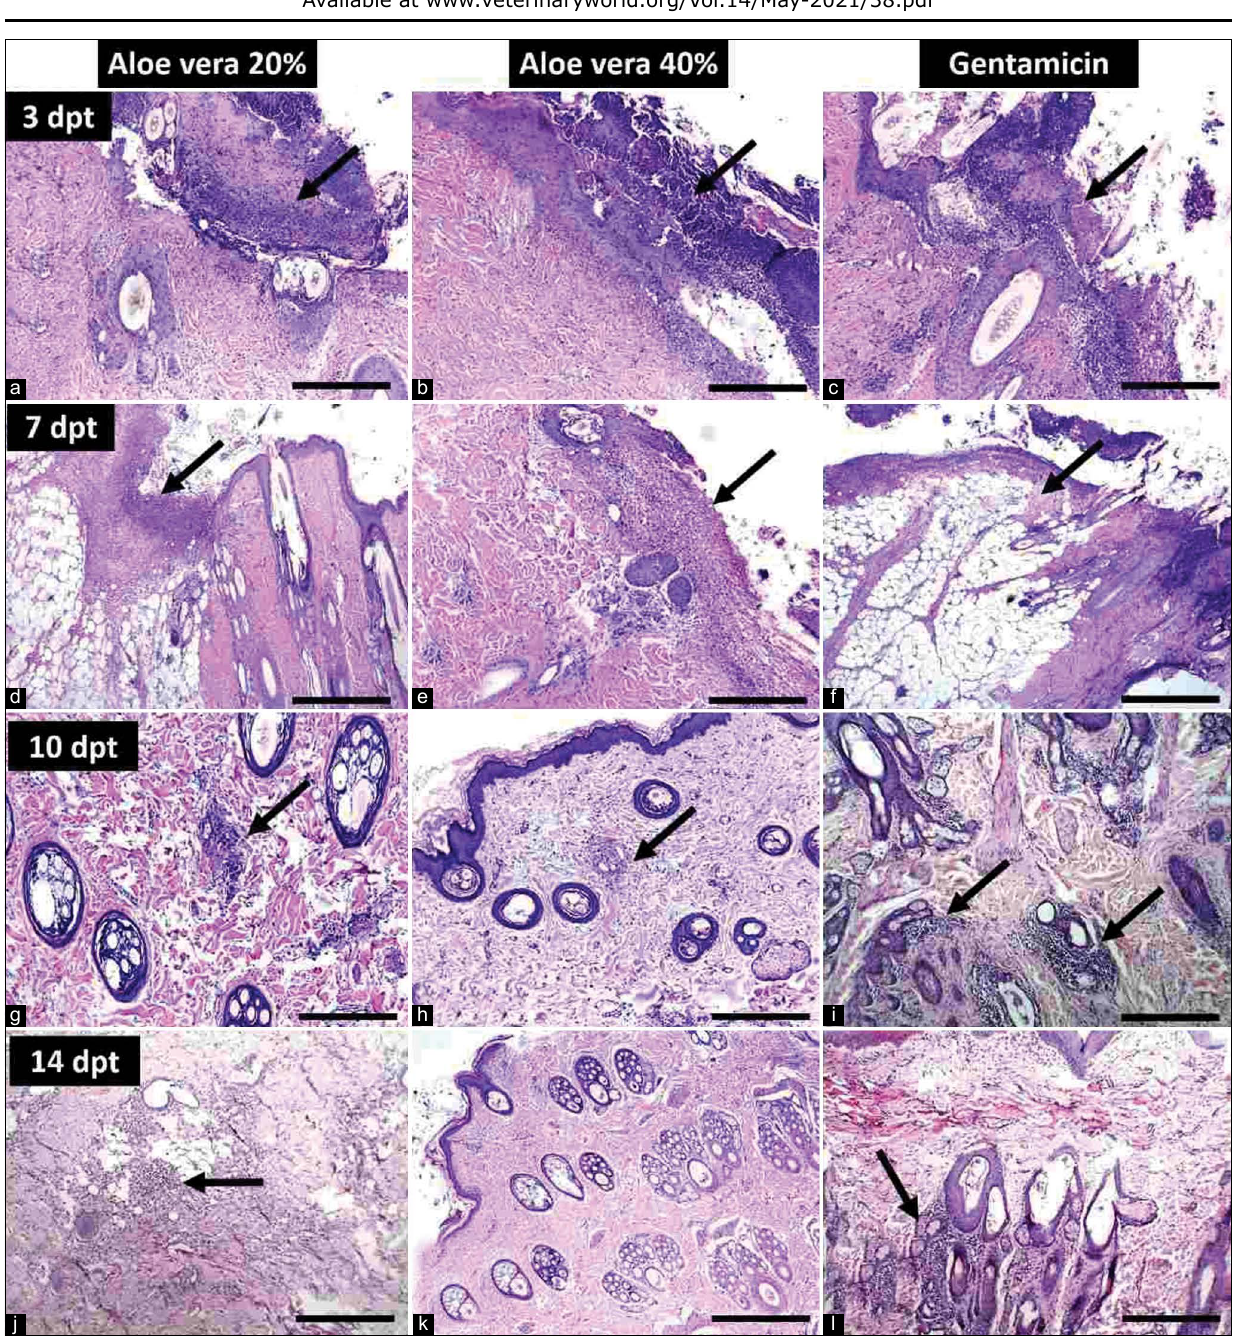
Figure-5: Treated group. On 3 rd days post-treatment (DPT), (a) skin treated with Aloe vera ointment 20% showed epidermal necrosis, edema, severe neutrophilic infiltration, and hair folliculitis; H and E 10×. (b) Skin treated with A. vera ointment 40% showed epidermal necrosis, edema, and moderate neutrophilic infiltration; H and E 10×. (c) Skin treated with gentamicin ointment 0.1% showed epidermal necrosis, edema, severe neutrophilic infiltration, and hair folliculitis; H and E 10×. On 7 th DPT, (d) Skin treated with A. vera ointment 20% showed focal suppurative inflammation in the subcutaneous fat; H and E 10×. (e) Skin treated with A. vera ointment 40% showed epidermal necrosis with few neutrophils’ infiltration; H and E 4×. (f) Skin treated with gentamicin ointment 0.1% showed diffuse suppurative inflammation in the epidermis and subcutaneous fat; H and E 4×. On 10 th DPT, (g) skin treated with A. vera ointment 20% showed mild inflammation in the dermis and around the hair follicles; H and E 10×. (h) Skin treated with A. vera ointment 40% showed mild inflammatory zone in the dermis; H and E 10×. (i) Skin treated with gentamicin ointment 0.1% showed mild inflammation around the hair follicles; H and E 10×. On 14 th DPT, (j) skin treated with A. vera ointment 20% showed mild inflammatory cells in the subcutaneous tissue; H and E 4×. (k) Skin treated with A. vera ointment 40% showed normal histological architecture of skin; H and E 4×. (l) Skin treated with gentamicin ointment 0.1% showed mild folliculitis; H and E 4×. Lesions are indicated by